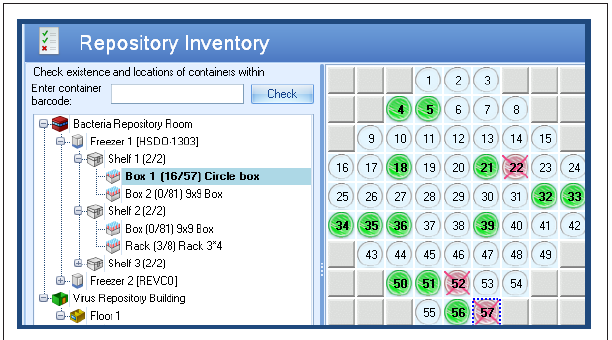
FIGURE 4: Repository inventory audit.